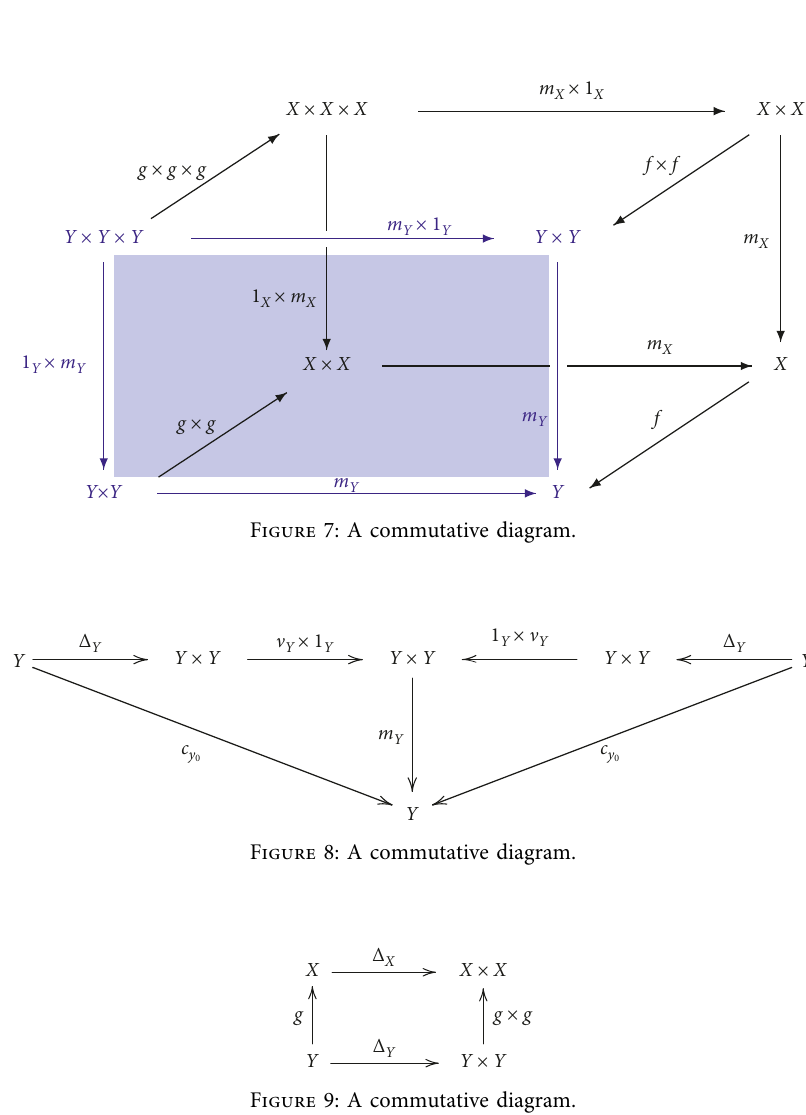
Figure 6: A commutative diagram.